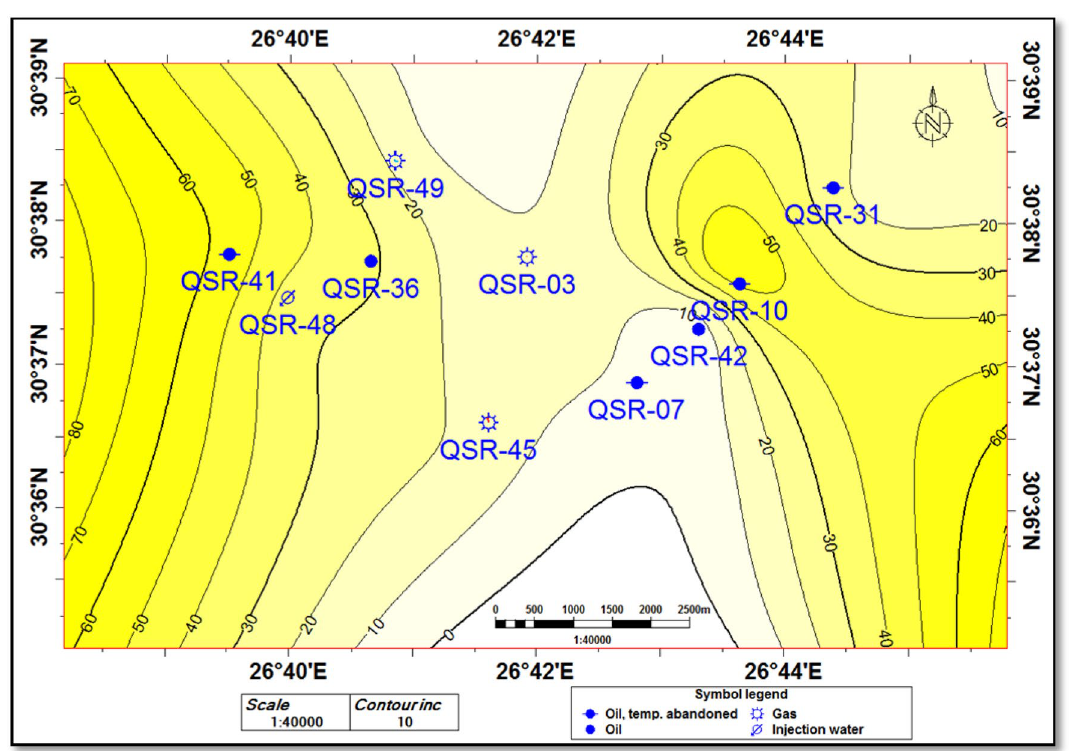
Fig. 5 AEB-3D (D2) sandstone isolith map (ft.)